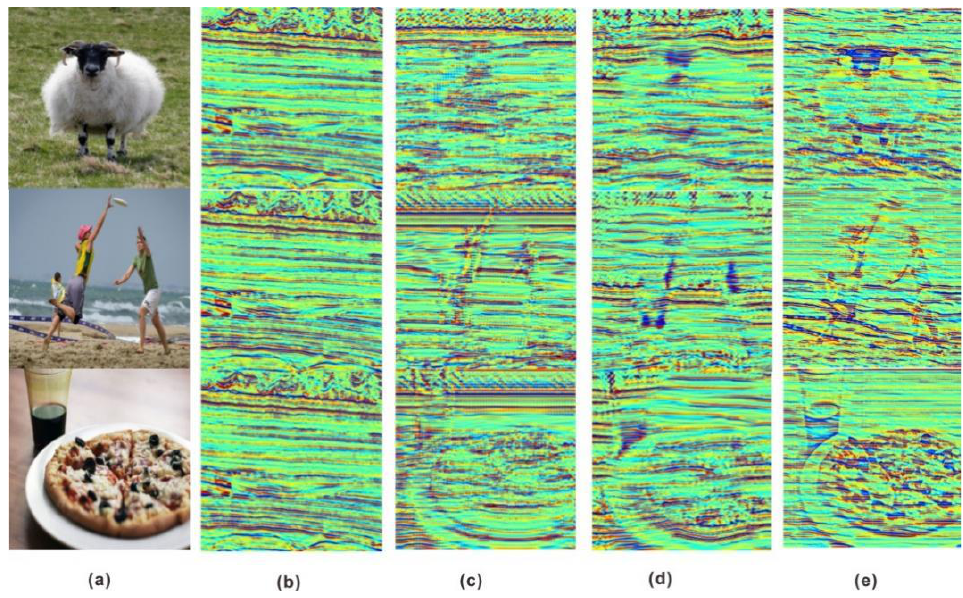
Figure 13. Comparison of experimental results. ( a ) Content; ( b ) Style; ( c ) The style transfer graph generated by CycleGAN model has serious content information loss. ( d ) The style transfer graph generated by U-GAT-IT model has serious content information loss and dark overall image color. ( e ) The content information of the style transfer graph generated by Lapstyle model is well preserved and the color is relatively prominent.